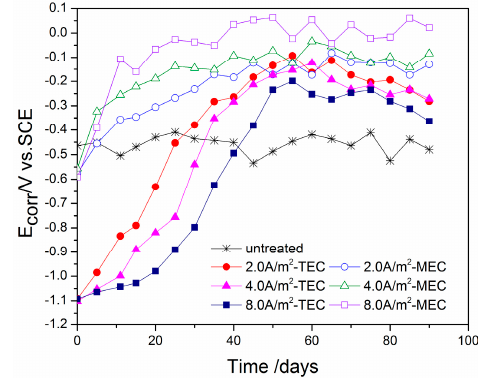
Figure 10. Changes of steel corrosion potential with time (untreated, after the TEC treatment and the MEC